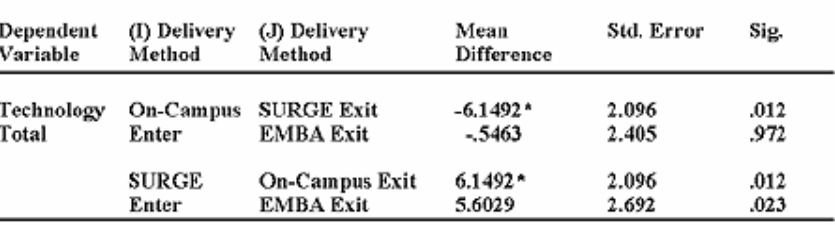
Table 7. Multiple comparisons (Tukey